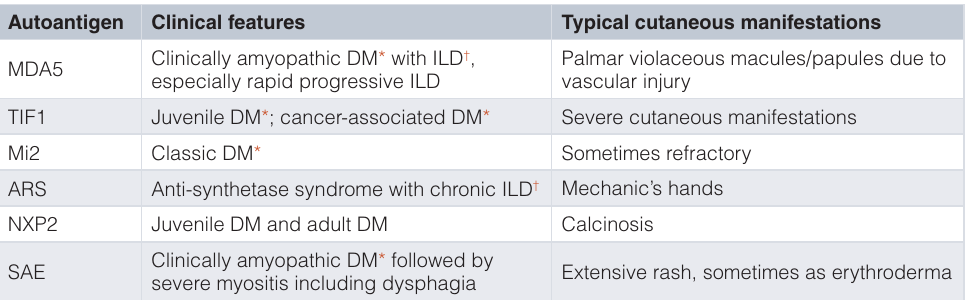
Table 1. Clinical features and cutaneous manifestations characterized by myositis-specific autoantibodies.